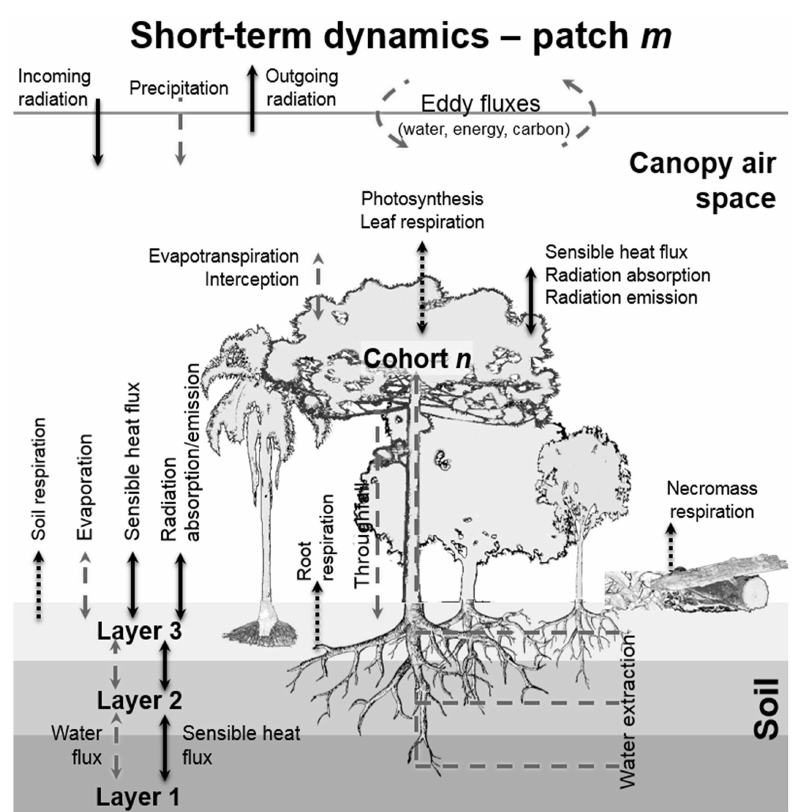
Figure 1. Schematic of the enthalpy fluxes (all arrows) and water fluxes (all but solid black arrows) that are solved in ED2. The schematic is based on Walko et al. (2000) and Medvigy et al. (2009). (Figure courtesy of Marcos